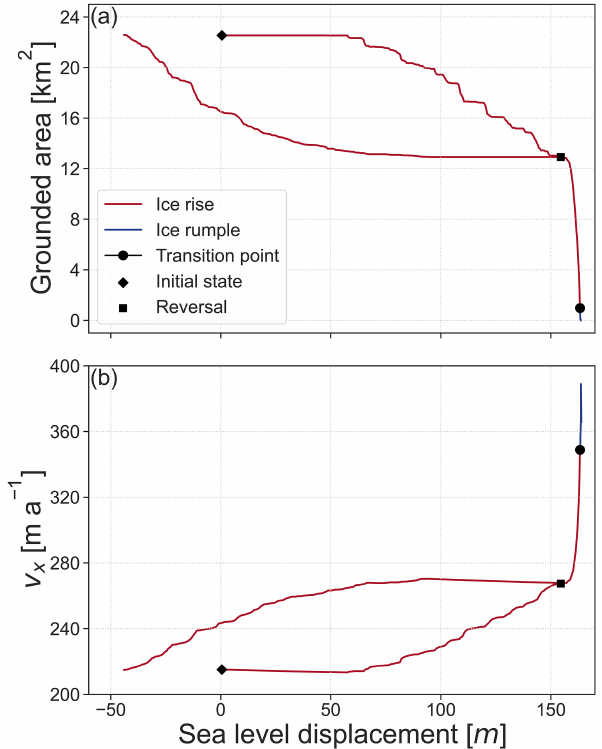
Figure 9. The response of grounded area and upstream ice shelf velocity to sea level perturbation in the case of high basal friction. In (a) , the grounded area is plotted against sea level displacement, and in (b) , the average velocity in the x direction in a cross-section upstream of the ice rise (at 20km from the influx boundary) is plot- ted against sea level displacement. Red indicates that the system ex- hibits a characteristic flow regime of an ice rise, and blue indicates that of an ice rumple. The square indicates from where a reversal of the sea level perturbation is